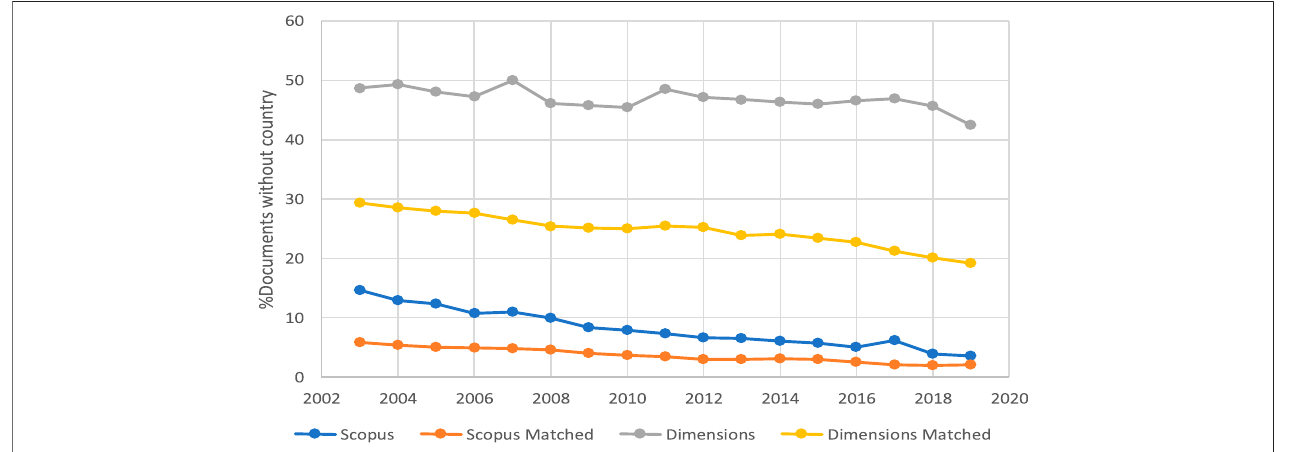
FIGURE 5 | Evolution of the annual percentage of items without country in the four subsets of documents belonging to Dimensions and Scopus.